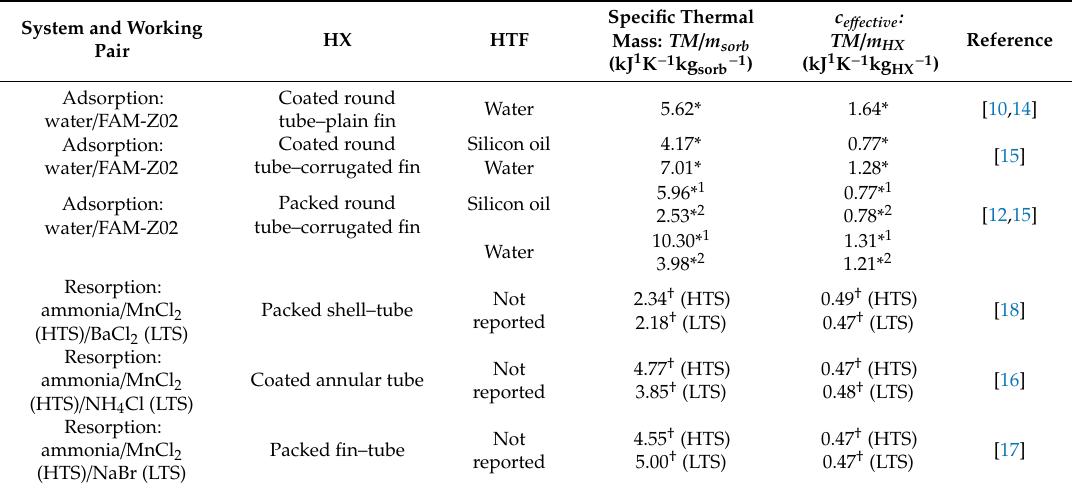
Table 2. Studies in the literature that provide all or some data needed to calculate heat exchanger (HX) thermal mass ( TM ). HTS, high-temperature salt; LTS, low-temperature salt. Specific Thermal System and Working HX HTF Mass: TM / m Pair